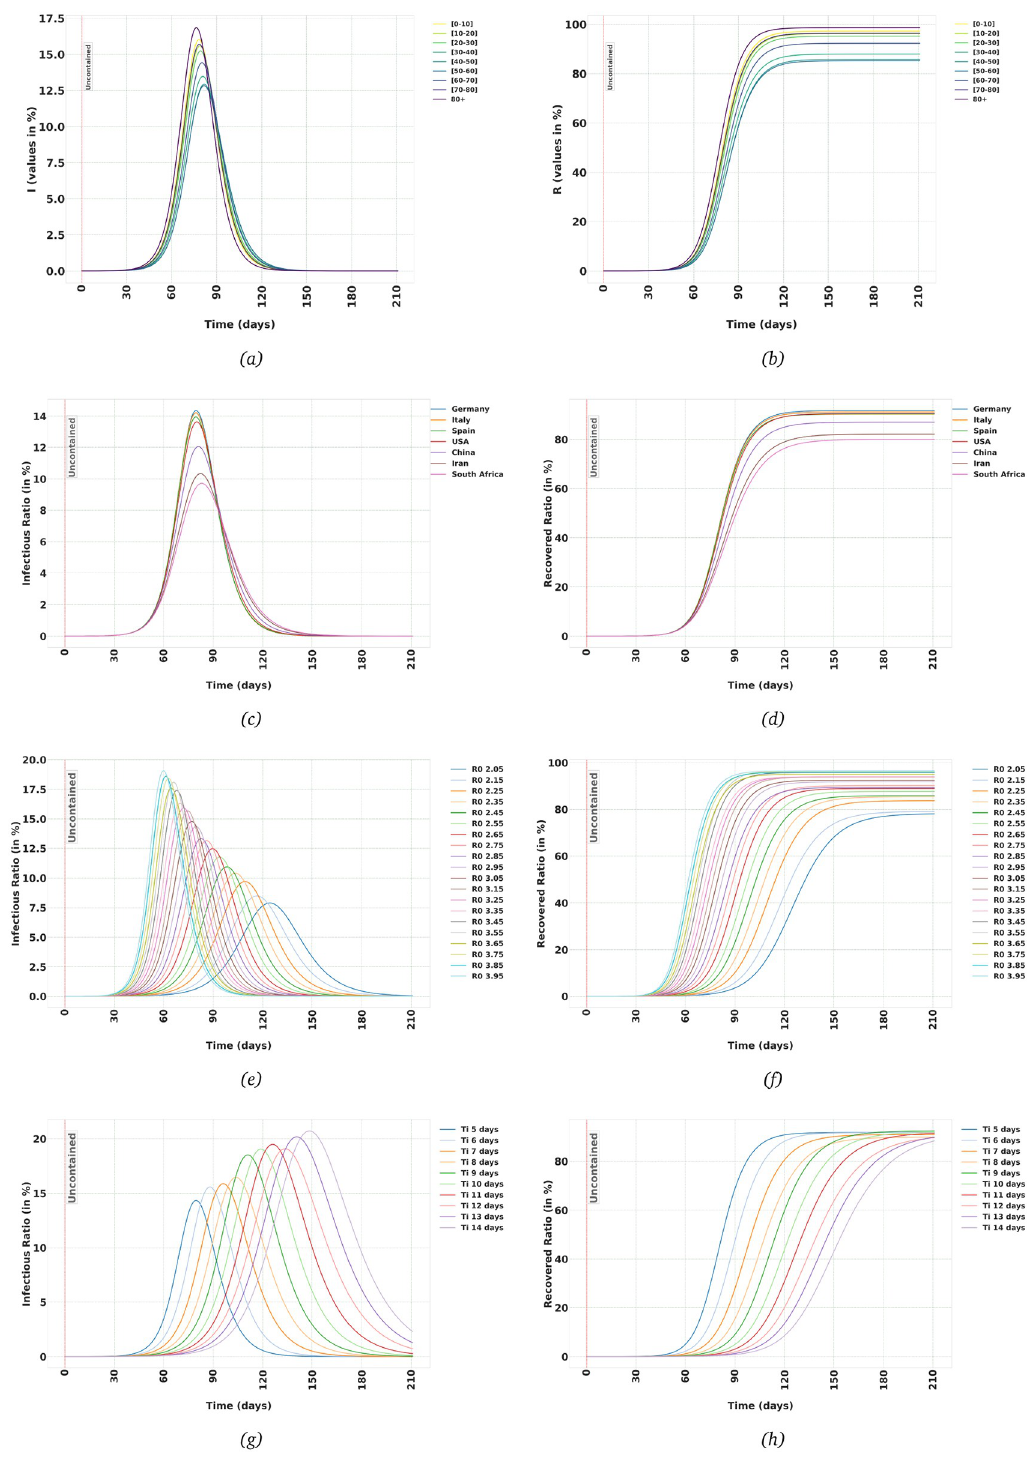
Fig 1. Uncontained scenario: (a,b) The Infectious and Recovered trajectories in the uncontained population in each age-group in Germany, (c,d) Aggregate trajectories of Infectious and Recovered in different countries. (e,f) Aggregate trajectories of Infectious and Recovered in Germany when R 0 in uncontained population assumes different values, (g,h) Aggregate trajectories of Infectious and Recovered in Germany with different values of T i (the average time-period hosts remain infectious).